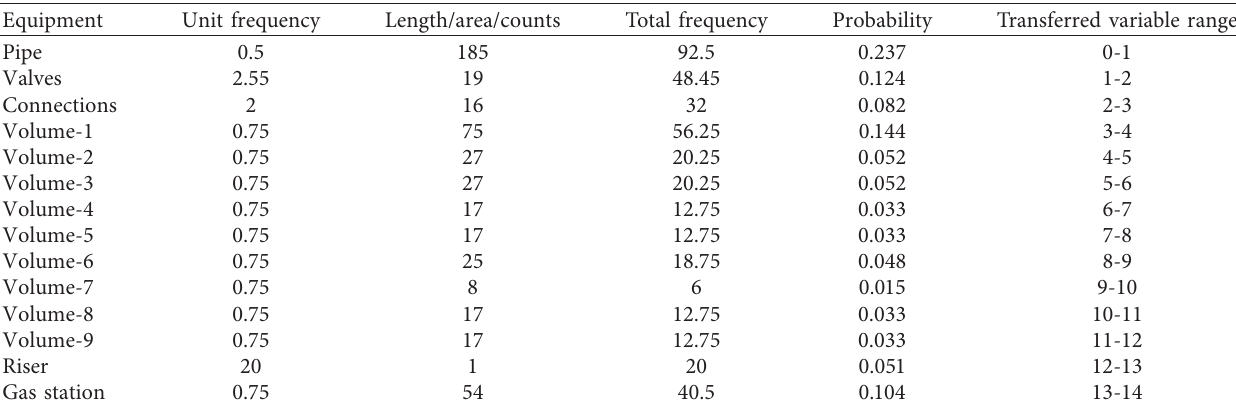
Figure 11: Main procedure to obtain the CDF of equipment groups. Table 1: Equipment group frequency calculation and corresponding transferred variable